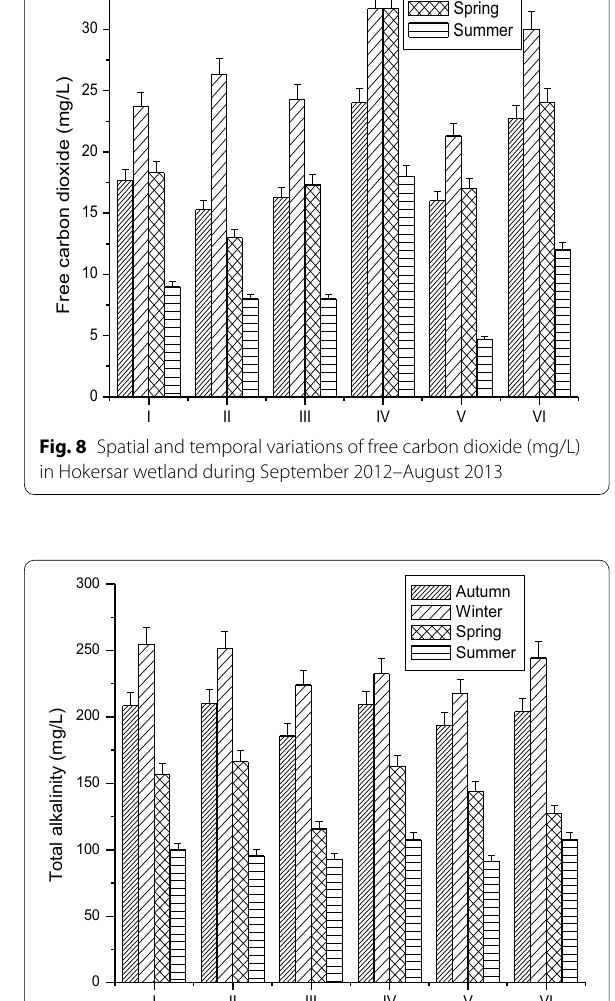
Fig. 9 Spatial and temporal variations of total alkalinity (mg/L) in Hokersar wetland during September 2012–August